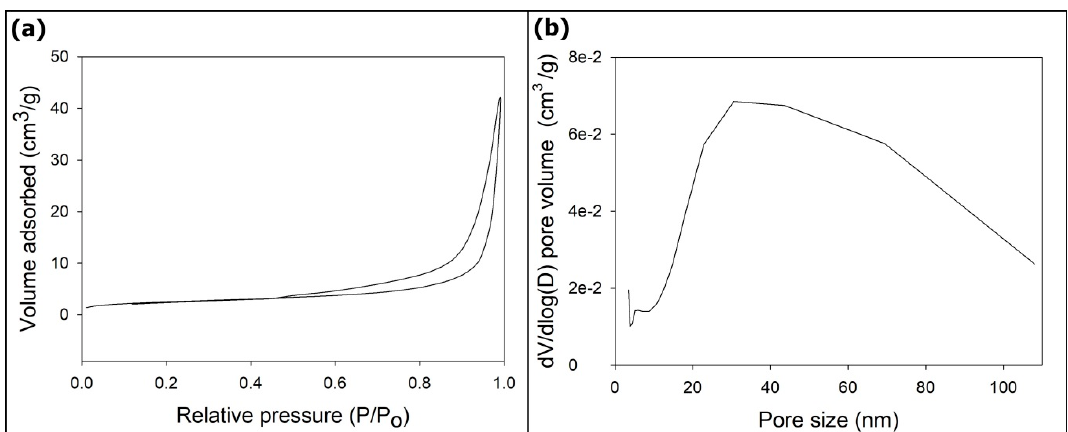
Figure 3. ( a ) N 2 adsorption-desorption isotherm and ( b ) pore size distribution curve of the HANFs.